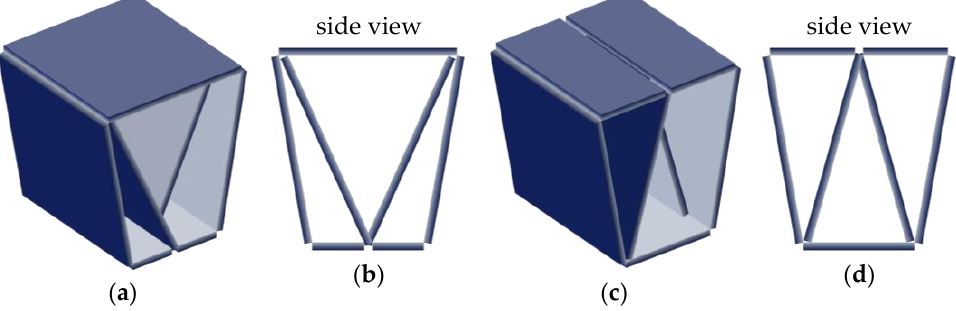
Figure 4. 2nd design with: ( a , b ) bottom discontinuity; ( c , d ) top discontinuity.